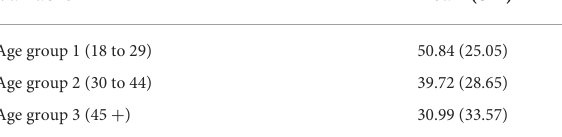
TABLE 3 Descriptive statistics and normality scores of the